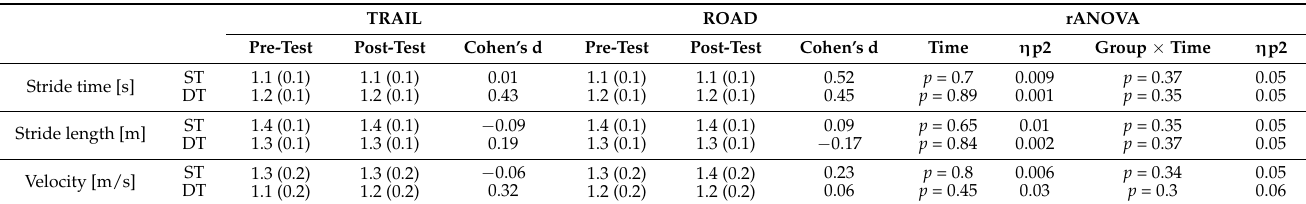
Table 4. Effect on spatio-temporal gait characteristics.